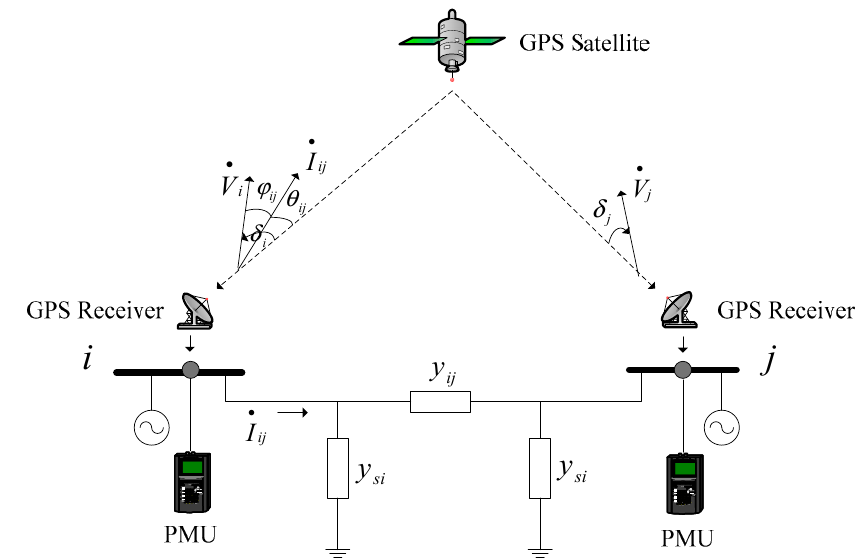
Figure 5. Power network model including PMUs.